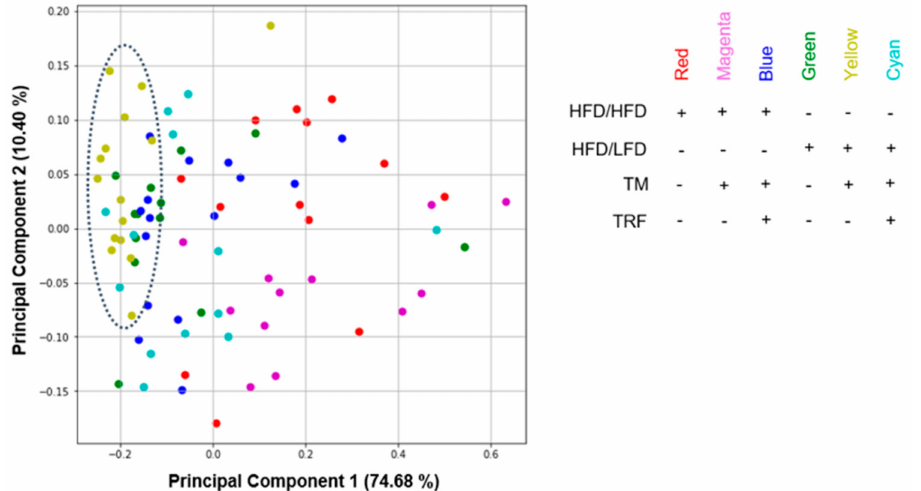
Figure 9. Dot plot of principal component analysis (PCA). All parameters from previously acquired experiments were further used for PCA construction ( n = 83 mice with 32 observations, see Table S1 for more information). Components from HFD/LFD + TM (yellow) and in parts from HFD/LFD (green) concentrate more on the left part of the diagram revealing less variance and more similarity (dotted circle). All PCA variables are listed in Table S4. Abbreviations: HFD: high-fat diet, LFD: low-fat diet, TM: treadmill, TRF: time-restricted